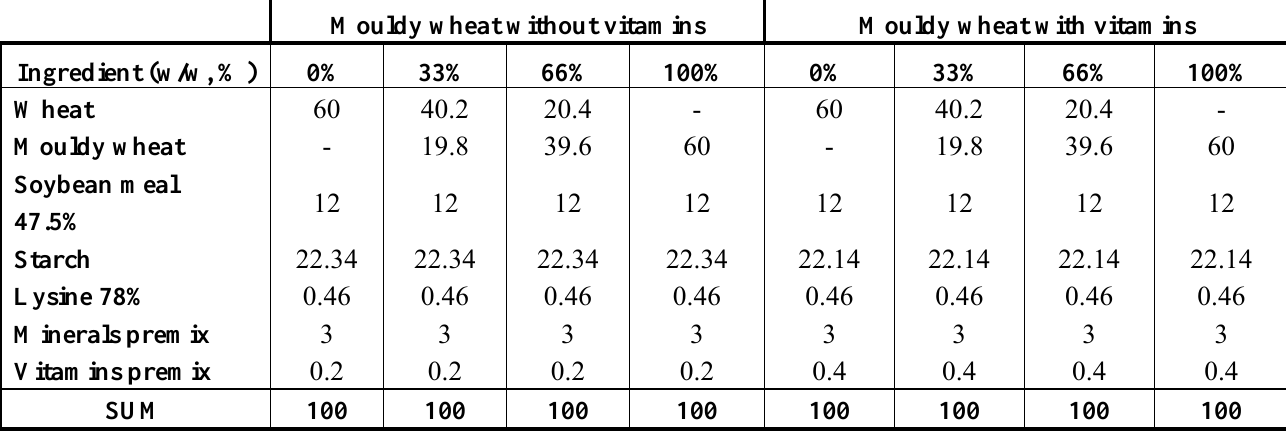
Table 1. Composition of feed mixtures.